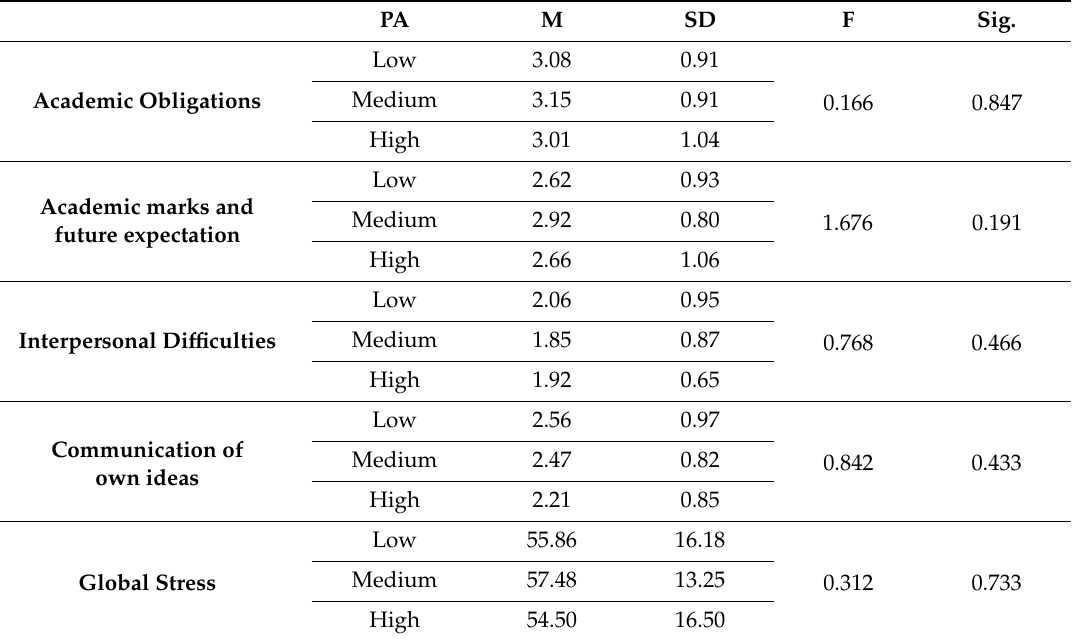
Table 4. Relationship between academic stress and physical activity.